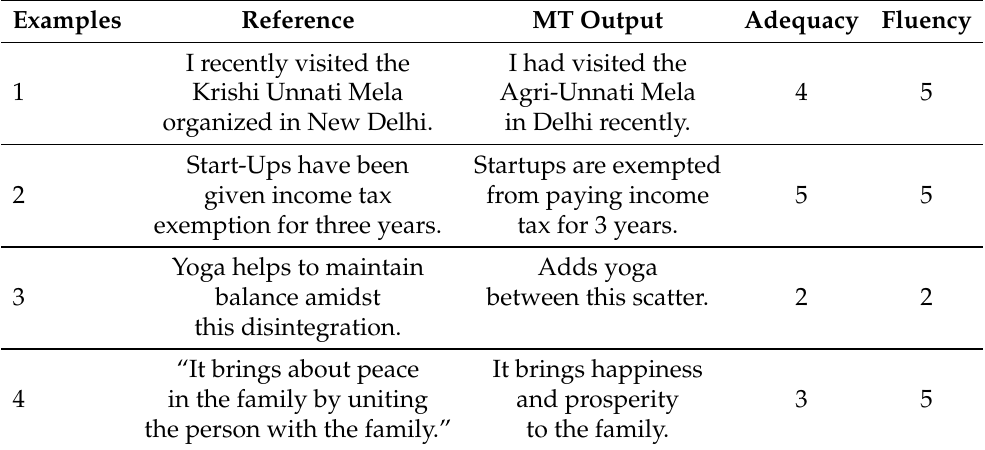
Table 8. Some example Hindi-to-English translation outputs with adequacy and fluency